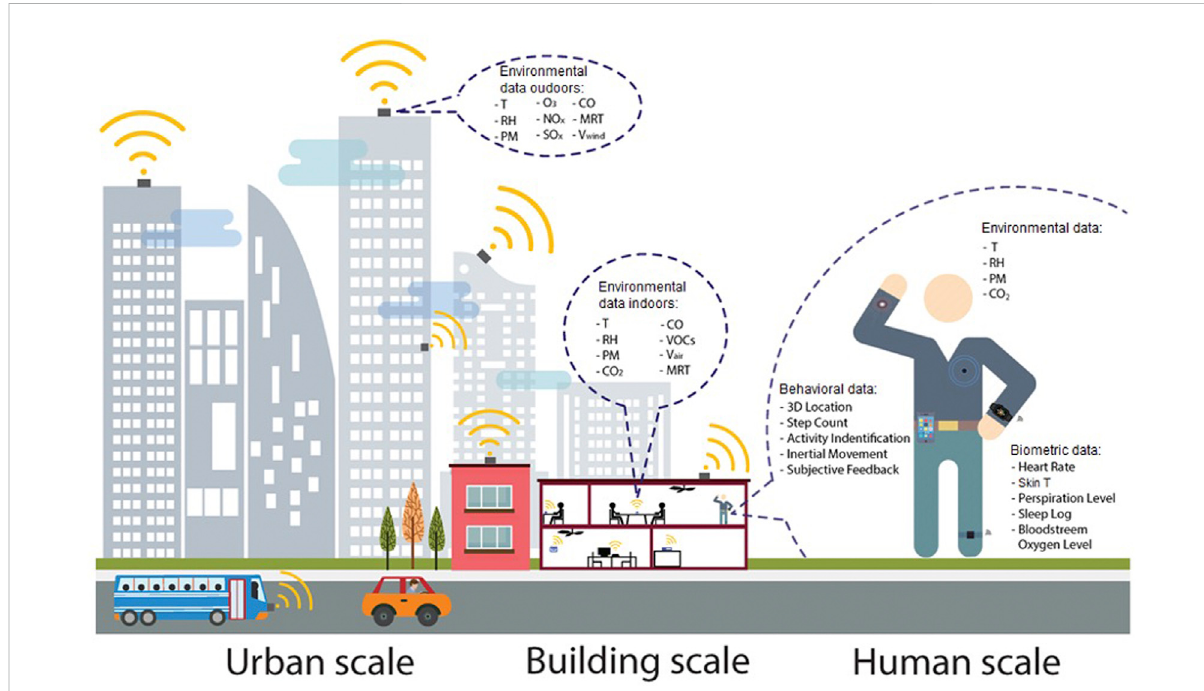
FIGURE 1 Schematic of IoT sensing applied to the built environment at the urban, building and human scales. The three scales encompass variations of environmental parameters, while the human scale also includes biometric (physiological) and behavioral